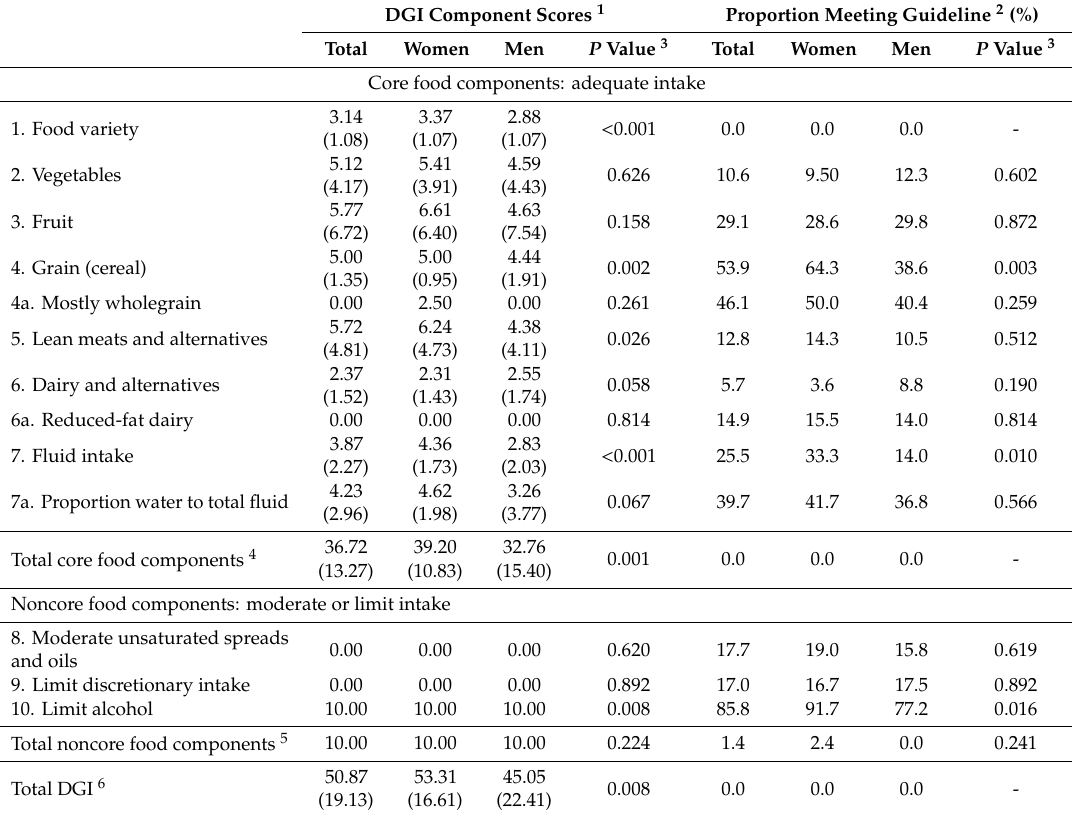
Table 3. Median scores and IQR for Dietary Guideline Index components, with proportion meeting Australian Dietary Guideline